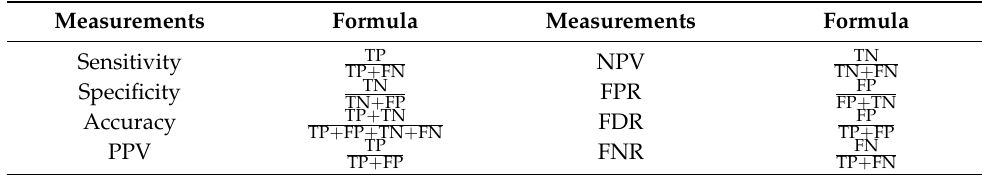
Table 1. Statistical equations to evaluate the IRT image segmentation